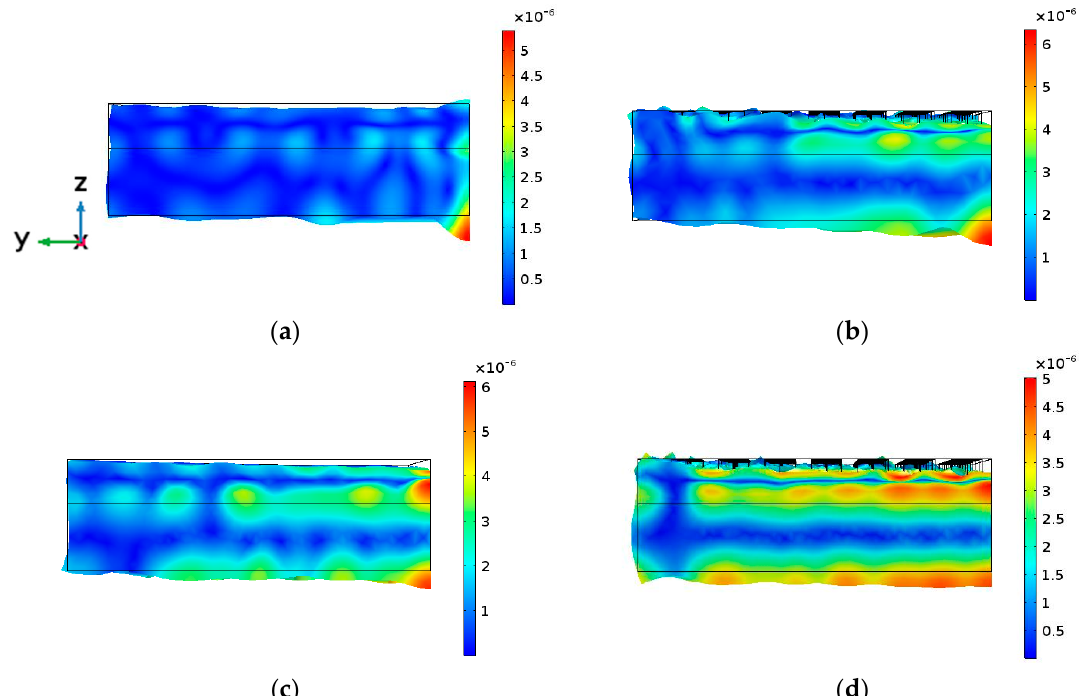
Figure 5. Maximum out-of-plane vibration amplitude at maximum elongation of the aluminum surface in the yz section, x = 0, of the transducer for 1 V excitation of the piezoceramic. ( a ) Model 1, ( b ) Model 2, ( c ) Model 3 and ( d ) Model 4. The bar scale is in mm. The frequency for each model was 997 kHz, 951 kHz, 988 kHz and 894 kHz, respectively.